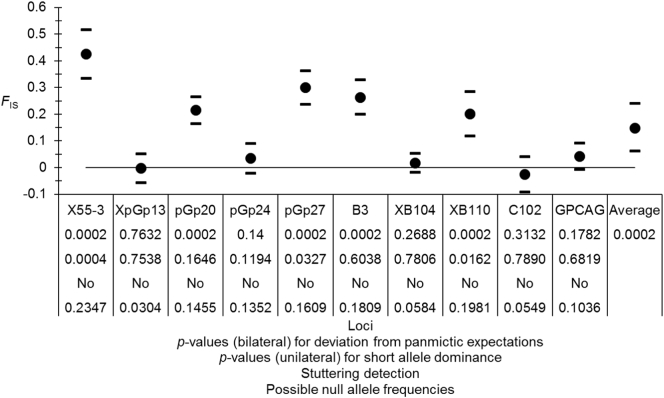
FIS observed in subsamples of females only of Glossina palpalis palpalis from Ivory Coast with jackknife's over subsamples 95% confidence intervals for each locus and 95% Bootstrap over loci confidence interval for the average. Results of panmictic tests, short allele dominance tests, stuttering detection and possible null allele frequencies are also given.